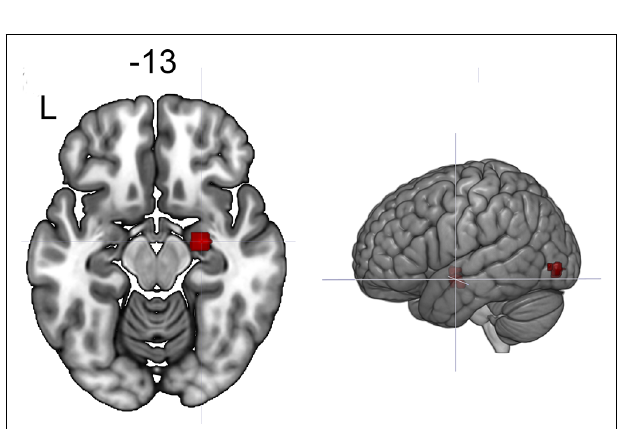
FIGURE 4 | Clusters showing increased connectivity with the left amygdala after neurofeedback. The connectivity map for intrinsic connectivity contrast post- vs. pre-neurofeedback is thresholded at p -FDR < 0.008 at the cluster-level with a cluster-defining voxel-wise statistical threshold of p < 0.001